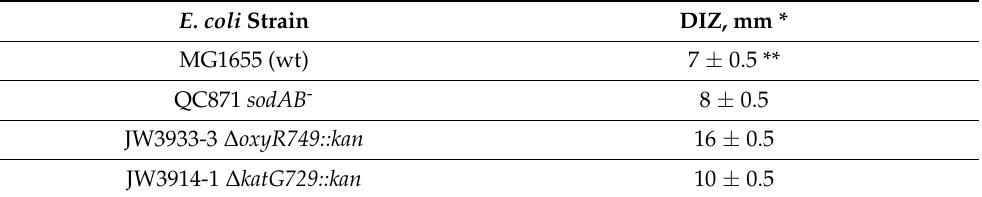
Table 2. Diameters of inhibition zone (DIZs) of different E. coli strains afterincubation with ( − )- limonene (4 µ L (3.36